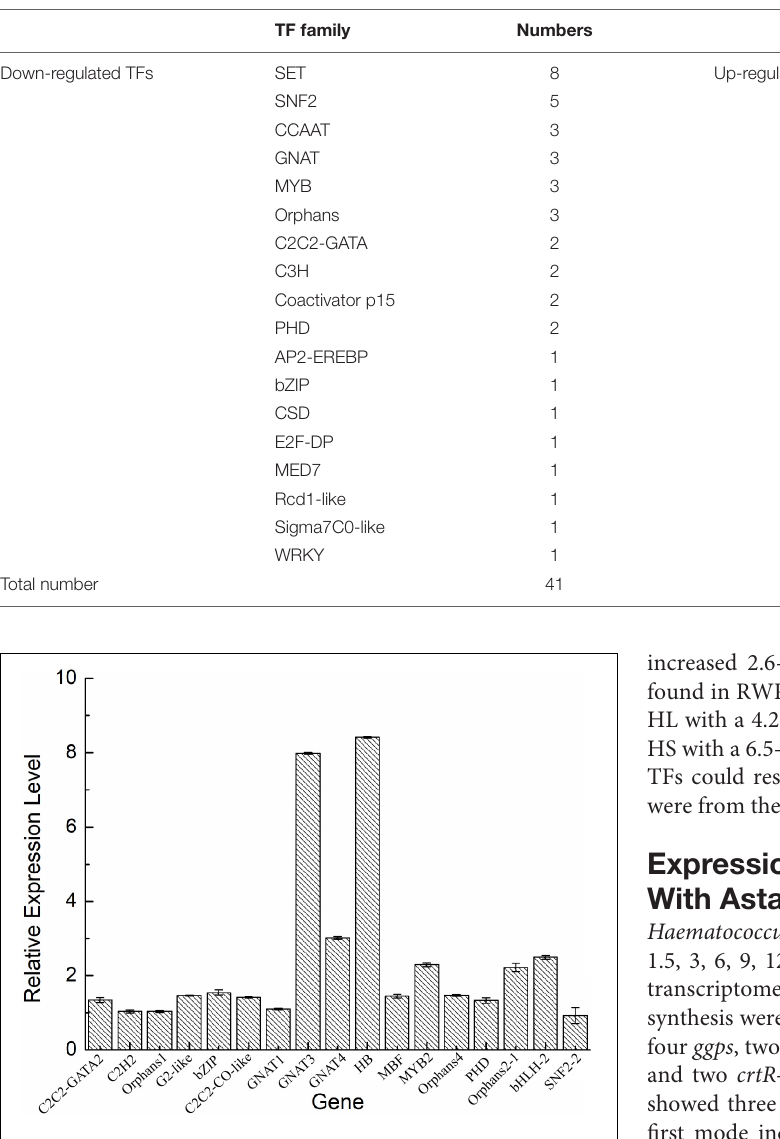
FIGURE 5 | Analysis of upregulated differentially expressed transcription factors (DETFs) by